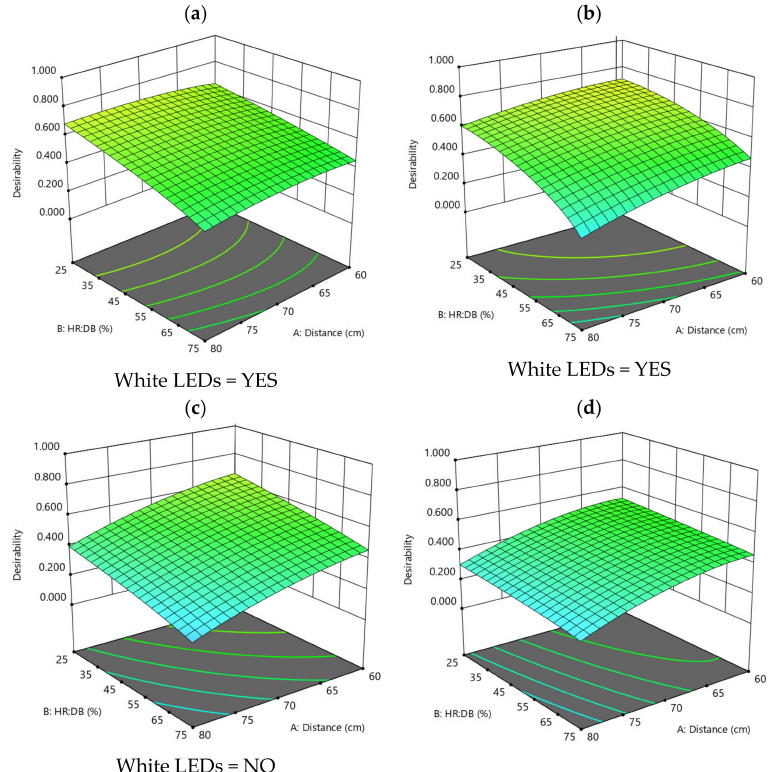
Figure 11. Contour plots of the desirability functions related to different periods: ( a ) 15D; ( b ) 20D; ( c ) 25D; ( d )